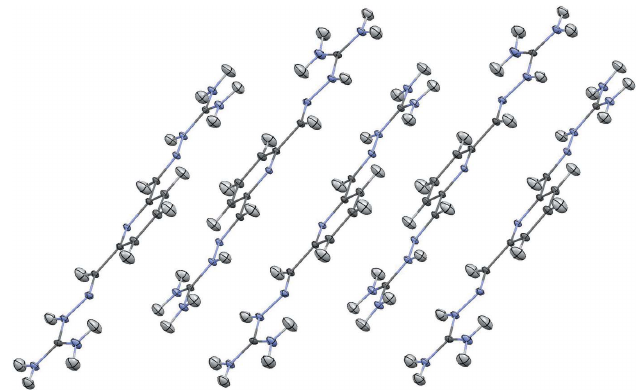
Figure 3 The stacking of PyBIGH 22+ cations. The figure is based on the neutron structure, with displacement ellipsoids drawn at the 20% probability level (Macrae et al. , 2008). Color scheme: nitrogen, blue; carbon, dark gray; hydrogen, light gray.